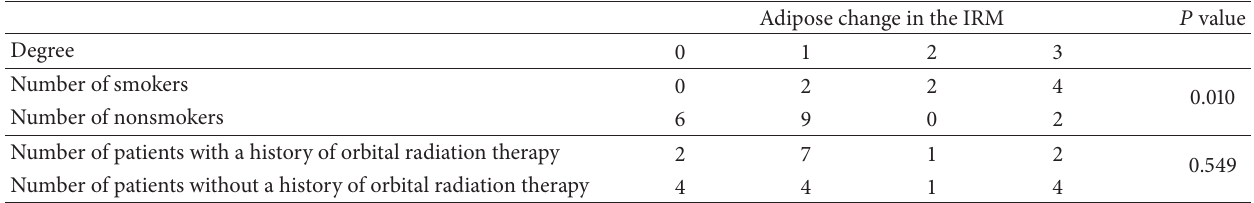
Adipose change in the IRM 𝑃 value